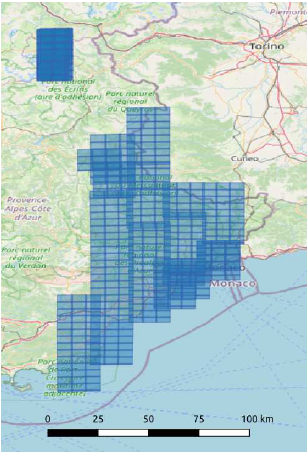
Figure 5: Footprints of CO3D image products covering PACA Benchmarks are carried out on the public infrastructure of OVH Cloud provider (French Cloud Provider). The processing